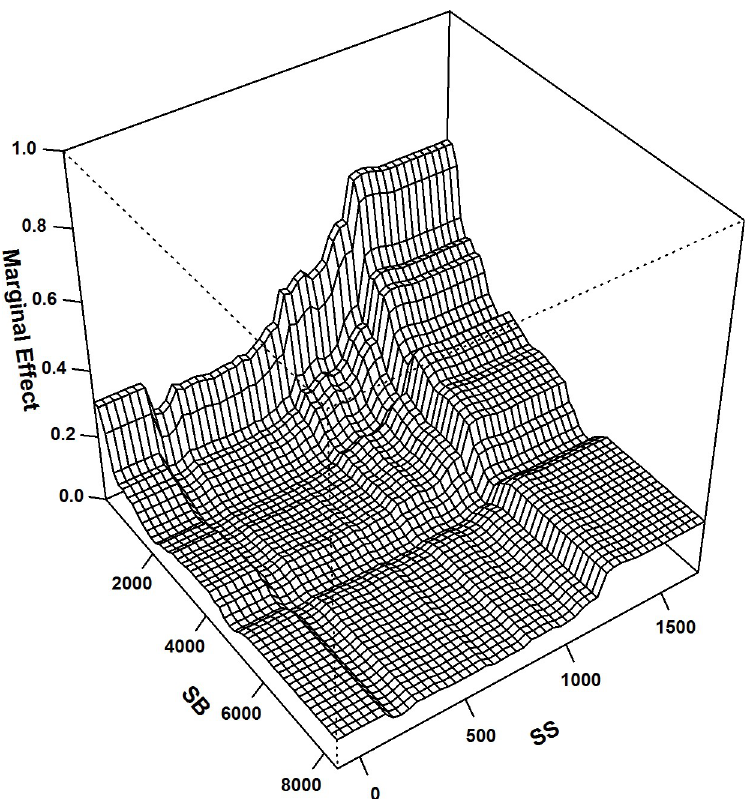
Fig 3. BRT 2-way: Interaction plot for distances to the edges of special biotas and the edges of settlements and structures; the most important interaction in the BRT 2-way model; interaction size = 0.58.